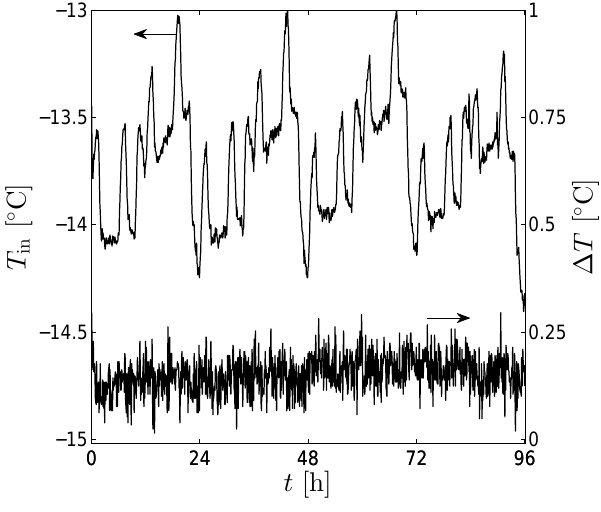
Figure 5. One minute averages of measured temperatures at the in- let T in and the temperature difference 1T = T in − T out between in- let and outlet of the snow sample. The locations of the sensors are shown in Fig. 2. Each local peak indicates one µ -CT scan, and the local temperature rises are induced by heating of the X-ray